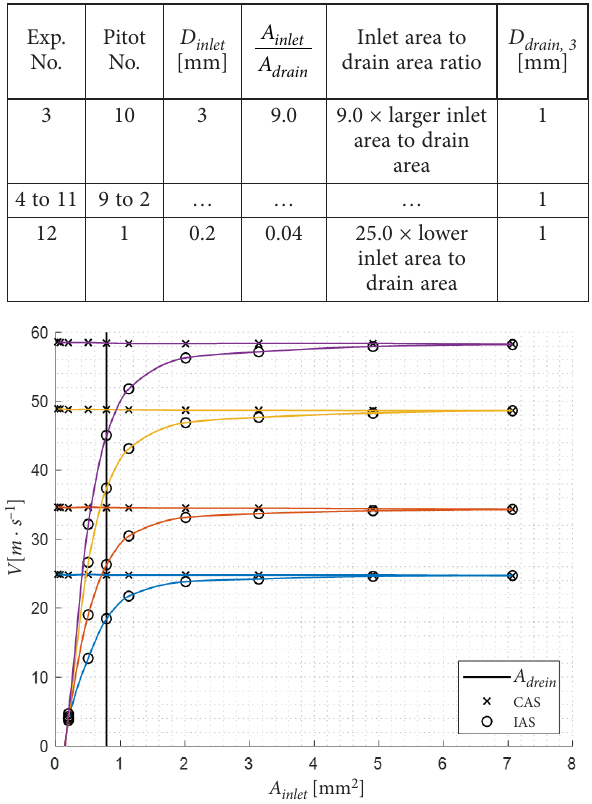
Figure 4. Indicated airspeed IAS on the inlet area for a pitot tube with 1 mm drain hole diameter